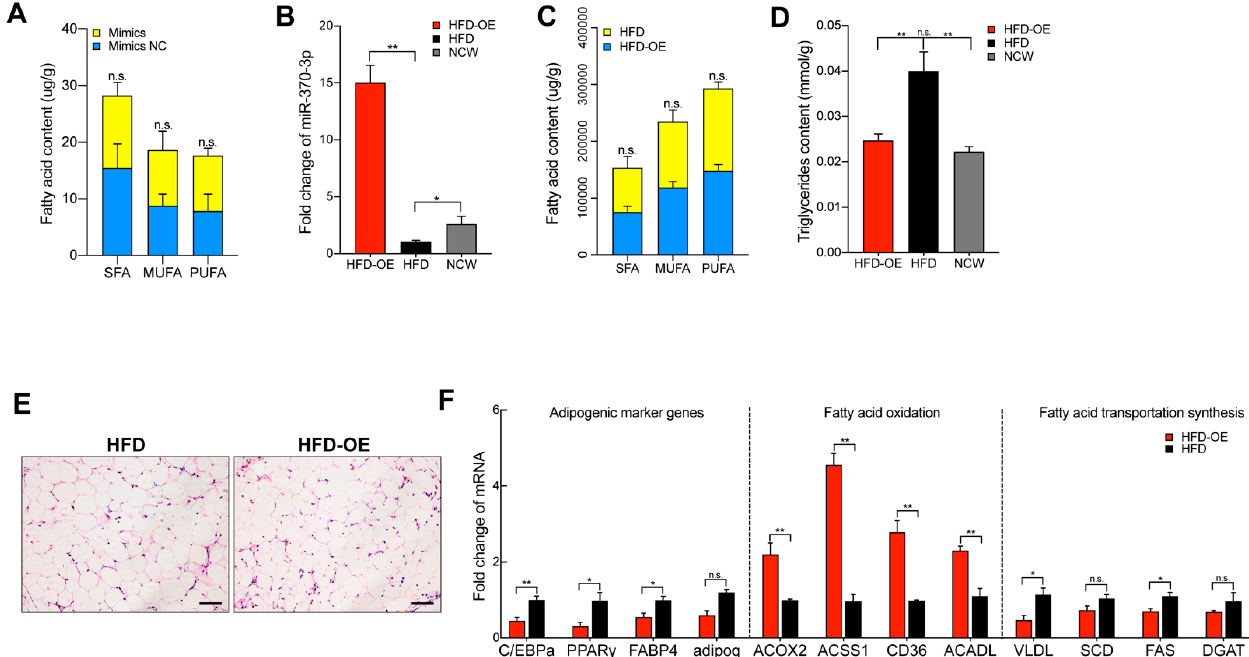
Figure 4. miR-370-3p regulates fatty acid composition both in vitro and in vivo. ( A ) Saturated fatty acids (SFA), monounsaturated fatty acids (MUFA), and polyunsaturated fatty acids (PUFA) content in mimic group and control group. ( B ) Measuring the expression of miR-370-3p in HFD-OE (high-fat-diet-induced obesity mice which overexpressed miR-370-3p), HFD- and NCW-fed mice. ( C ) SFA, MUFA, PUFA content in HFD and HFD-OE. ( D ) Triglyceride content. ( E ) H&E staining for adipose tissues from HFD and HFD-OE. ( F ) The mRNA levels of C/EBPa, PPAR γ , FABP4, adipoq, ACOX2, ACSS1, CD36, ACADL, VLDL, SCD, FAS, and DGAT were measured by qRT-PCR. Scale bars 50 μ m. All results are presented as means ± SEM. n = 3 per treatment. Each treatment represents the mean of three replicates. * p < 0.05; ** p < 0.01, n.s. no significant difference. Table 2. miR-370-3p regulates fatty acid composition in